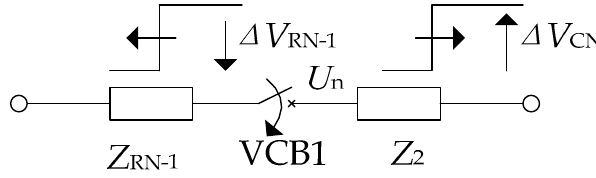
Figure 13. The overvoltage waveform across VCB1.